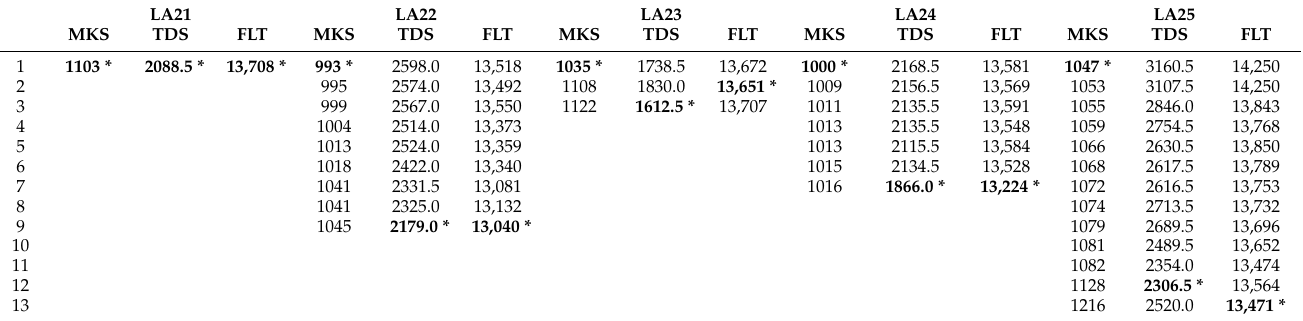
Table A16. Non-dominated solutions obtained by SS/CMOTA for the JSSP instances proposed by